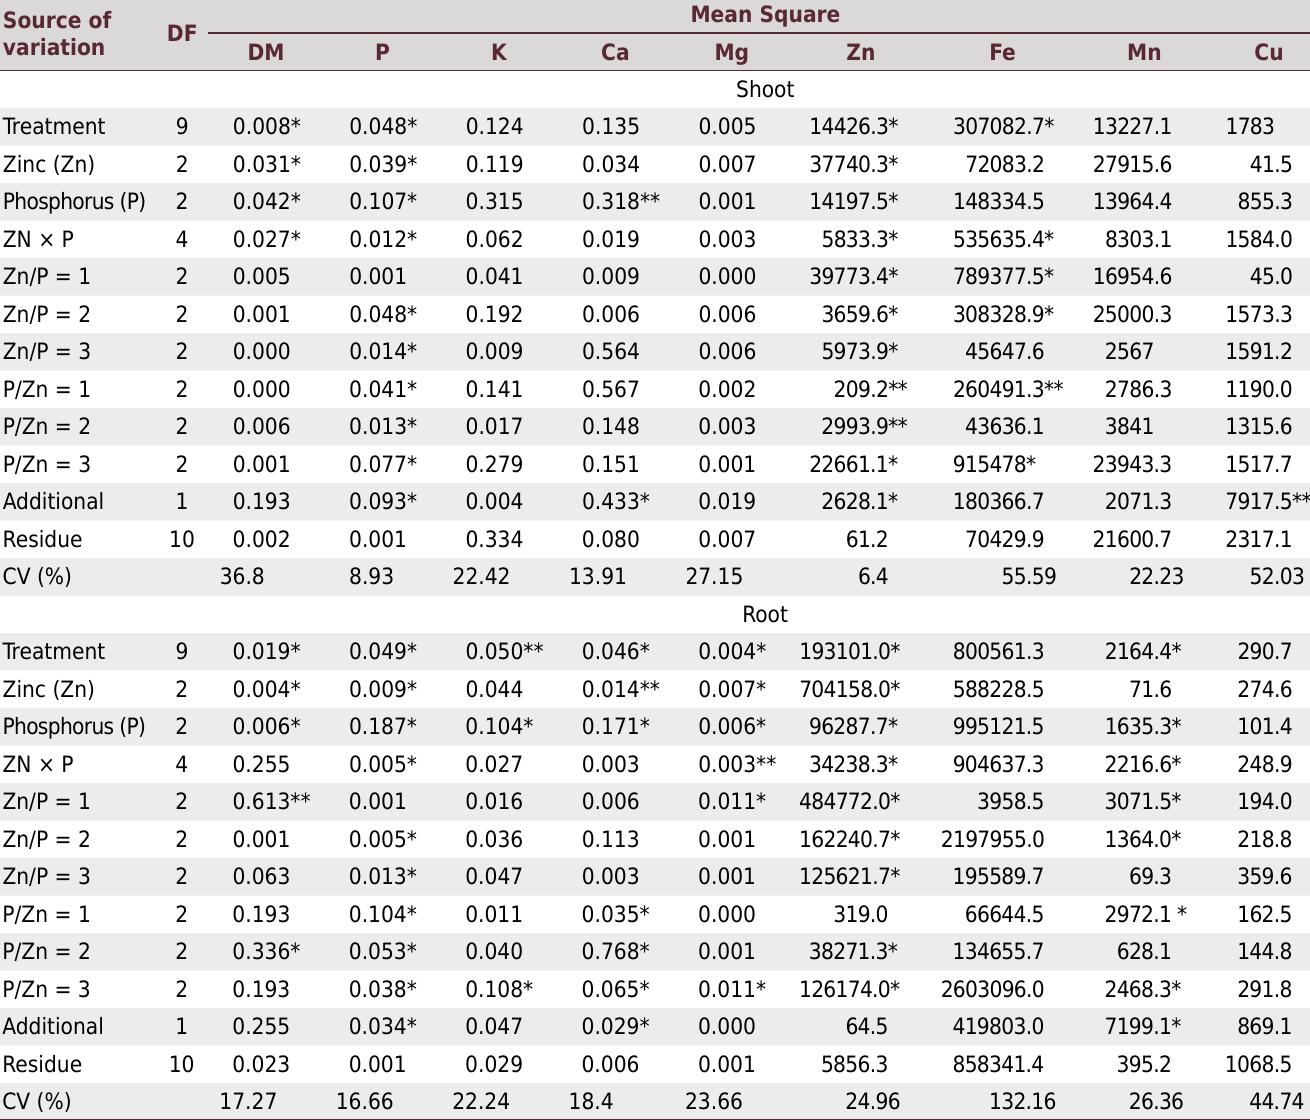
Table 2. Analysis of variance of dry matter (DM) and macro- and micronutrient content in the leaves and roots of Phalaenopsis spp Source of